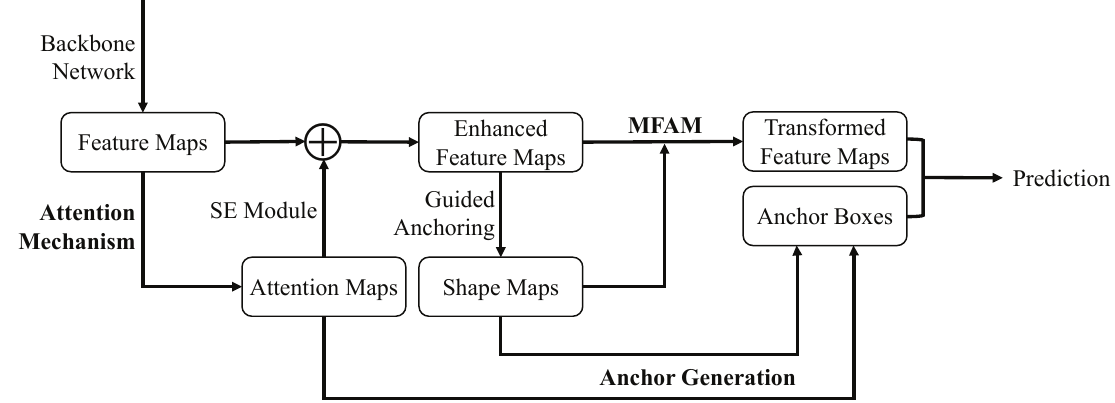
Figure 1. The schematic of the proposed detection